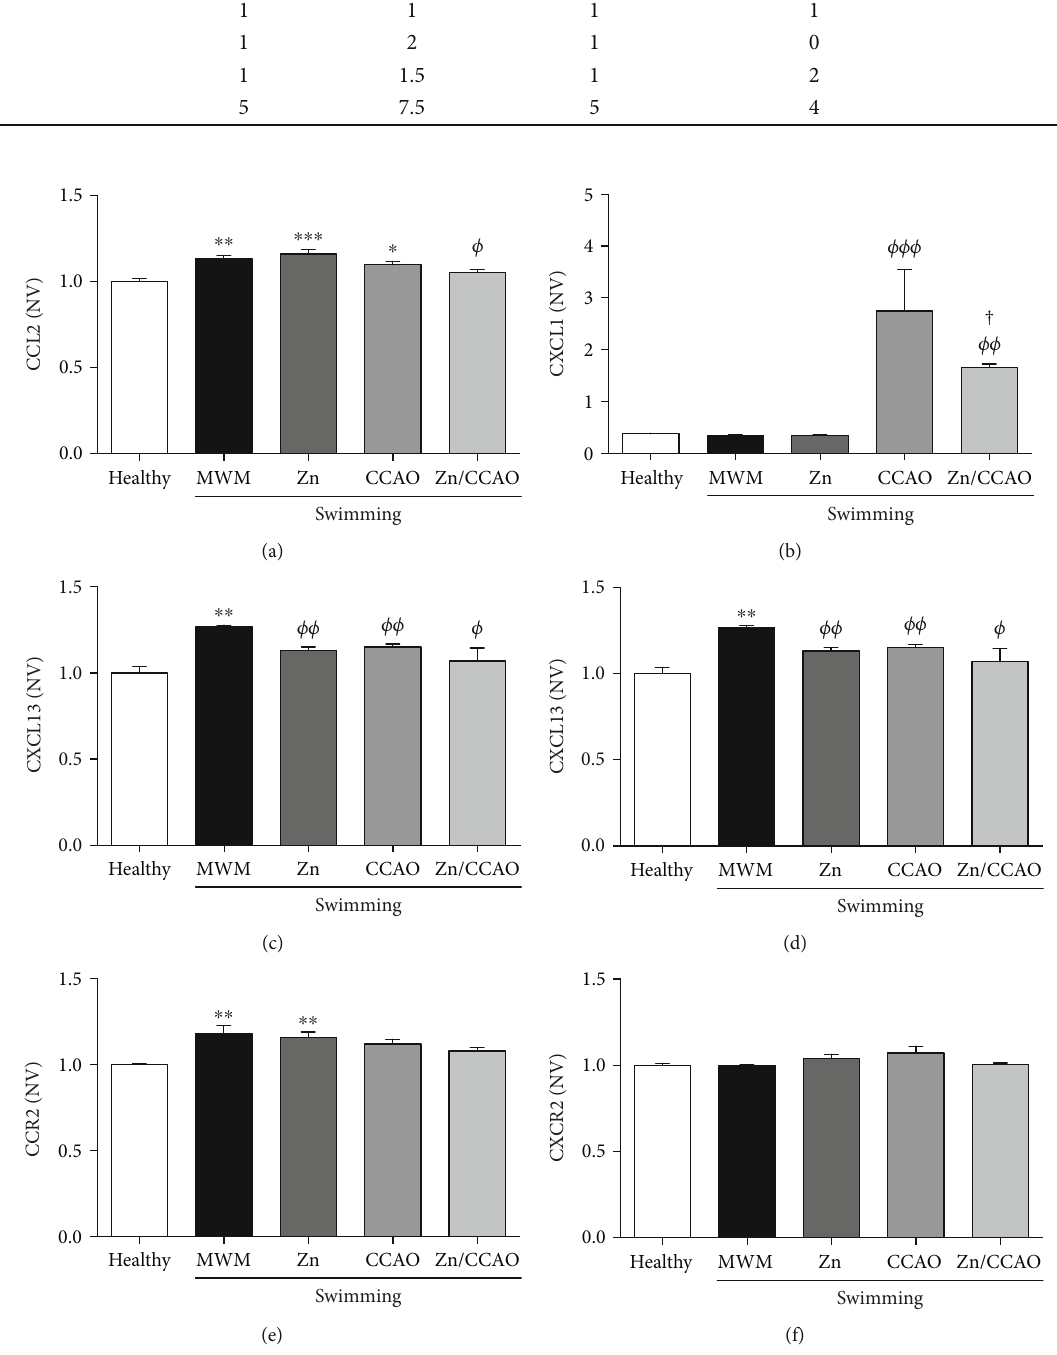
Figure 9: The subacute prophylactic zinc administration and swimming partially prevented the CXCL1 increase induced by 30min CCAO in the temporoparietal cortex on day 12 postreperfusion. The values are mean ± SEM ( n = 4 ) and analyzed with one-way ANOVA and Dunnett ’ s post hoc multiple comparisons. ∗ P < 0 : 05 , compared with the control group, Φ compared with the MWM group, and † compared with the CCAO group. NV: normalized